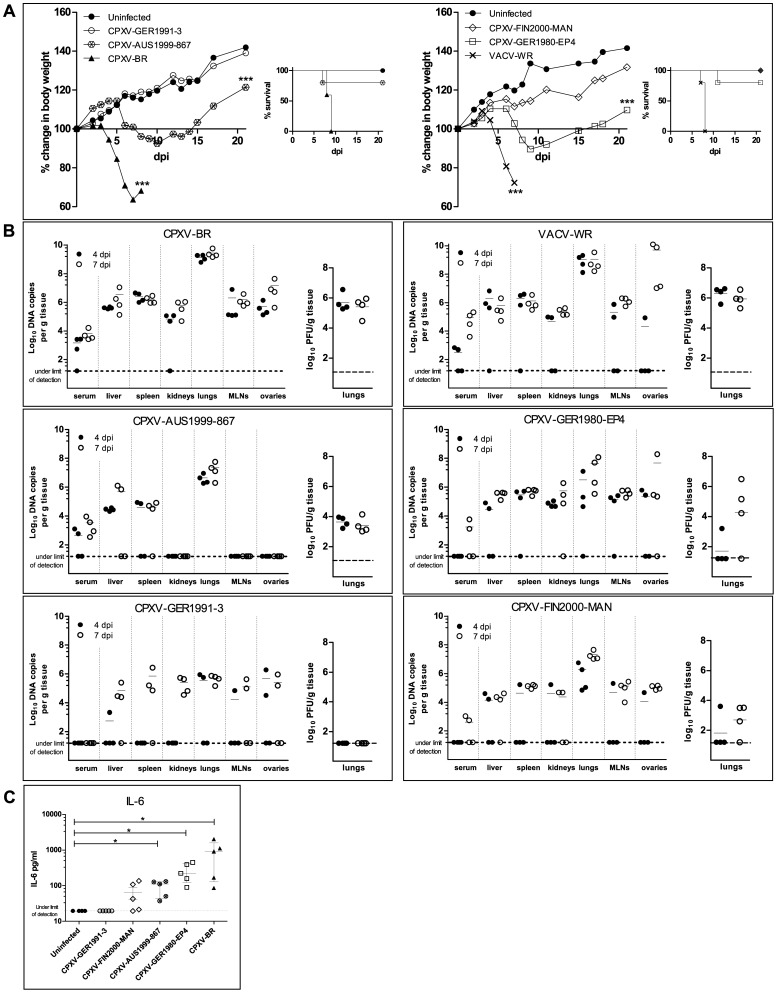
Virulence of CPXVs, virus distribution in tissues and cytokine levels in the sera.Animals were challenged intranasally with 10,000 PFU/mouse with VACV-WR, CPXV-BR, CPXV-GER1980-EP4, CPXV-GER1991-3, CPXV-AUS1999-867 and CPXV-FIN2000-MAN (13 mice per group). (A) Body weight evolution, survival curves of each group are given, and are representative of two independent experiments. *** (p<0.001), the body weight of uninfected animals differs significantly from that of infected mice (one-way analysis of variance (ANOVA) associated with a Dunnett’s multiple comparison test). (B) Viral loads in sera and organs (left graph) and lung virus titers (right graph) are shown. The virus strain is indicated on top of each graph. Viral loads were determined by qPCR and are expressed as log10 DNA copy numbers per 50 µl of serum or per g of tissue for liver, spleen, kidneys, lungs, MLNs and ovaries. Lung virus titers are shown in log10 PFU per g of lung tissue. Four individual mice per group and per time point were used. Symbols: 4 dpi (•) and 7 dpi (○), and dashed line represents the limit of detection. (C) IL-6 production in the sera of mice is shown. Sera were collected at day 7 pi after exposure to PBS or to virus. Data are the median ± interquartile range (n  = 4 or 5 mice for each group). *p = 0.0179, IL-6 level of virus-infected mice differs significantly from that of the uninfected group by Mann-Whitney test.